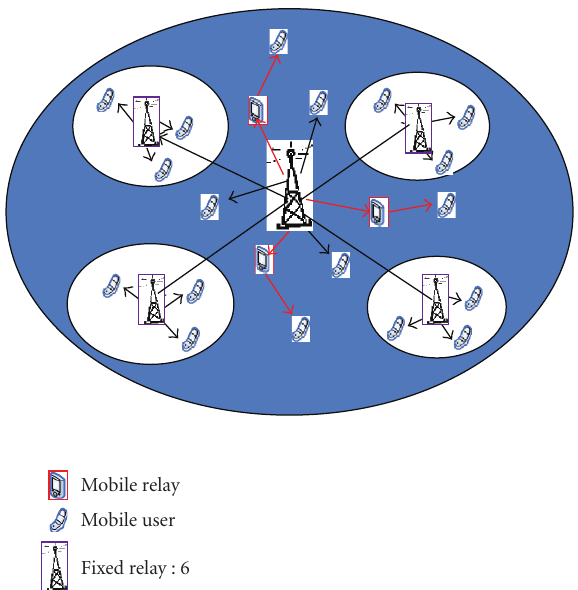
Figure 8: Cellular layouts for fixed and mobile relay nodes.